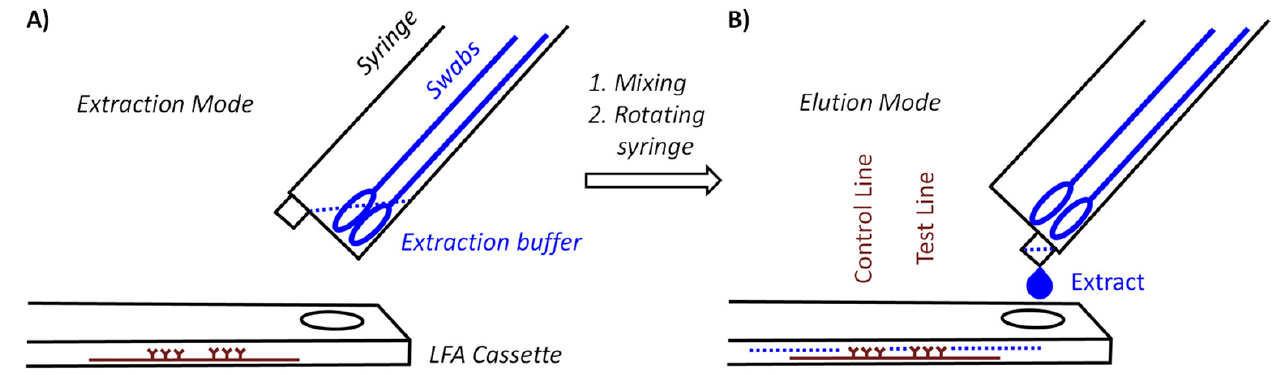
Figure 1. Principle of pooling and extraction in a syringe acting as a container and elution onto a lateral flow assay (LFA) cassette for analysis. ( A ) Container in extraction mode; thorough mixing is induced by rotating the bundle and moving individual swabs. ( B ) Elution, induced by rotating the syringe by 180° to allow for the extract to drip onto specimen well of the LFA cassette.